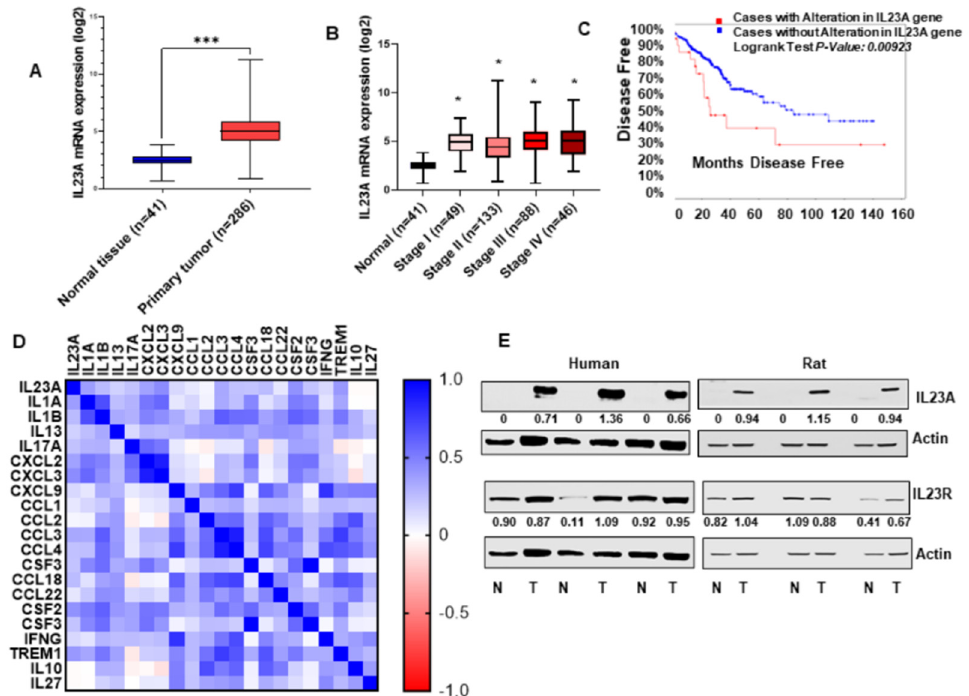
Figure 1. IL-23A expression in human colon adenocarcinoma. ( A ) The TCGA COAD database of 551 patients showed a higher mRNA expression of IL-23A in the primary tumor samples than in normal solid tissues. ( B ) The pathological stage of the COAD dataset demonstrated that mRNA expression of IL-23A is highly upregulated in all stages of colorectal adenocarcinoma, compared with normal solid tissues. ( C ) Kaplan–Meier survival curve analysis showed that patients with high IL-23A gene expression had low disease-free survival compared with patients with low IL-23A gene expression. ( D ) IL-23A mRNA and mRNA of cytokines and chemokines were downloaded from the COAD dataset of the TCGA database. The difference in the color indicates a correlation of IL-23A with other genes, positive (blue) and negative (red). ( E ) IL-23A and IL-23R protein expressions in human and rat, colon tumors and their matched normal colon tissues. Band intensity ratio was measured using GelQuant software. * p < 0.05, and *** p < 0.001 were considered statistically